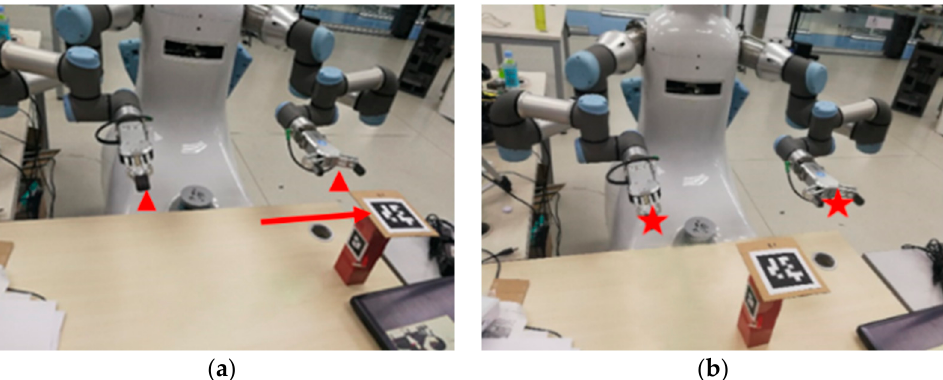
Figure 8. Renderings of Reach task of the physical robot. ( a ) The image obtained by the camera. The two triangles represent the current position of the fingers and the QR code used by Apriltags is pointed to by the arrow. ( b ) The selected target points are left and right points in the air, which are 10 cm above the QR code.